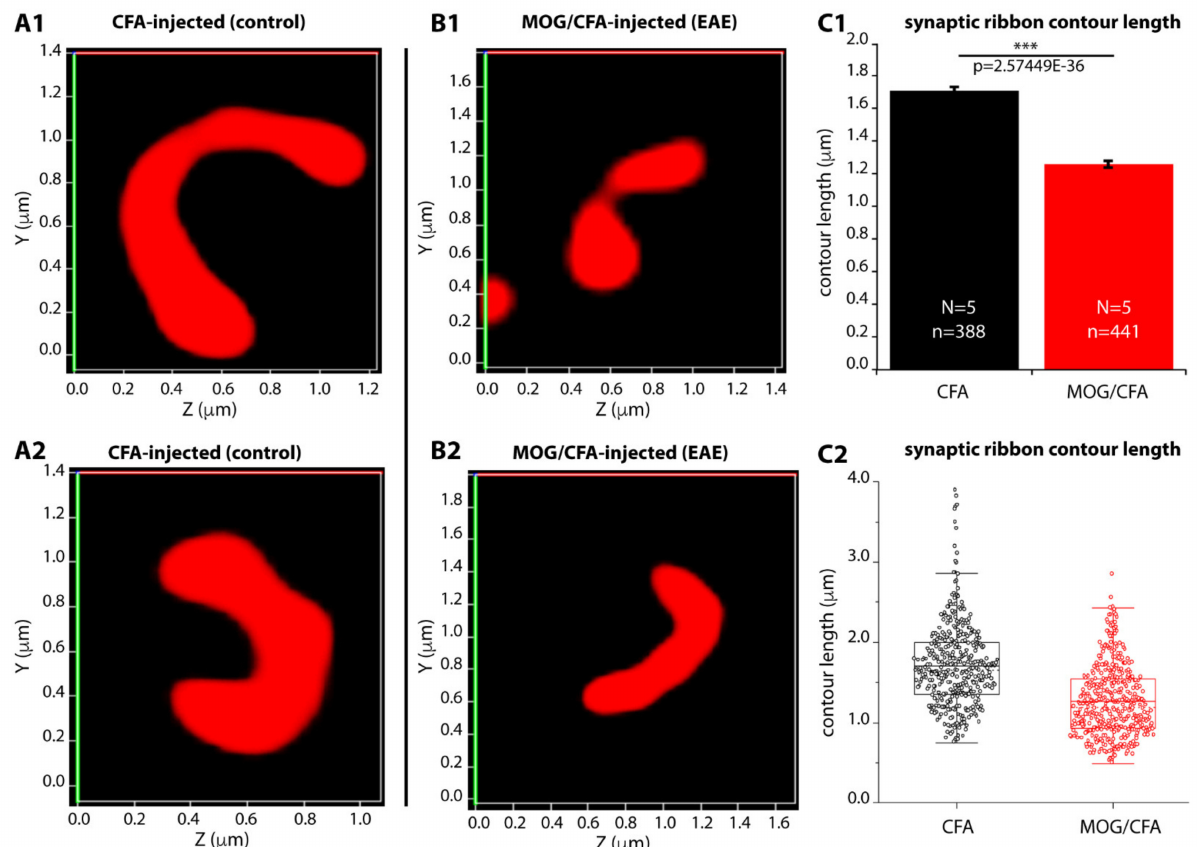
Figure 3. Contour length of rod photoreceptor synaptic ribbon is reduced in early pre-clinical EAE mice in comparison to control mice. ( A1 – B2 ) Representative 3D SR-SIM images of individual synaptic ribbons from rod photoreceptor synapses of CFA-injected control mice ( A1 , A2 ) and MOG/CFA-injected EAE mice ( B1 , B2 ) immunolabelled with mouse monoclonal antibody against RIBEYE (2D9). ( C1 , C2 ) Quantitative analyses of the contour lengths of rod photoreceptor synaptic ribbons measured as maximum 2D projections from the 3D SR-SIM images (see also Figure 1). Values in ( C1 ) are means ± S.E.M. (1.71 ± 0.02 µ m in CFA-injected control mice; 1.26 ± 0.02 µ m in MOG/CFA-injected EAE mice). In the box-and-whiskers plot ( C2 ) of the data from ( C1 ), mean values are indicated by solid horizontal lines; median values by dotted horizontal lines. Boxes represent the 25th–75th percentiles of data points and whiskers are equal to 1.5 times of the interquartile range (IQR). Mann–Whitney U-test was used to determine the statistical significance. N, number of mice; n, number of analyzed 3D SR-SIM images; ***, p ≤